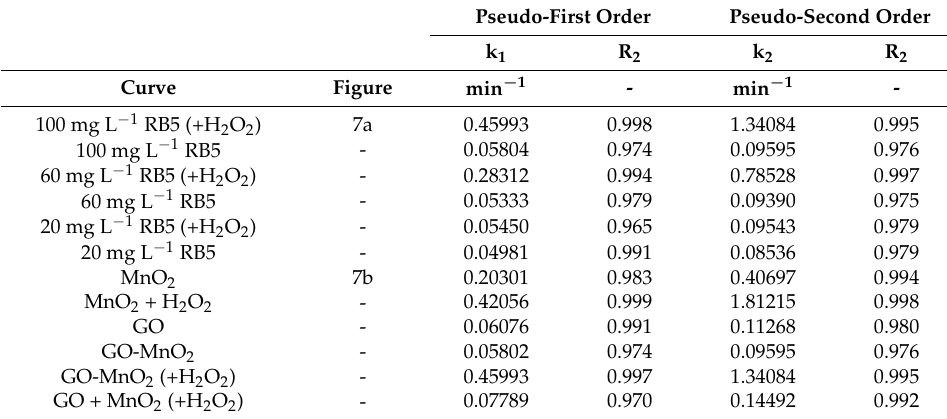
Table 2. Kinetic parameters for the RB5 degradation related to Figure 6a,b. Pseudo-First Order Pseudo-Second